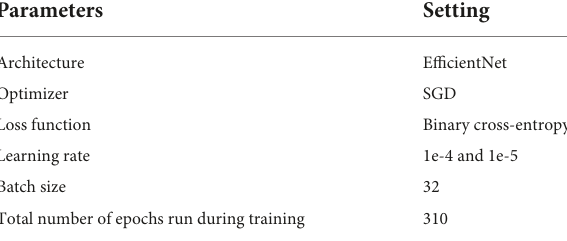
TABLE 1 The details of the final trained